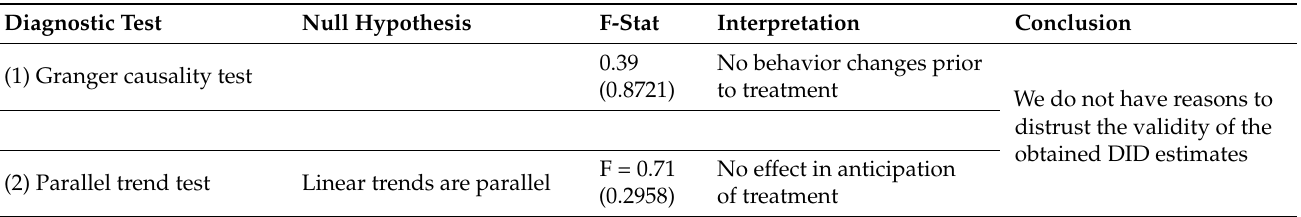
Figure 5. Parallel trend results of carbon emissions. Table 4. Results of Granger causality and parallel trend Table 4. Results of Granger causality and parallel trend analysis.